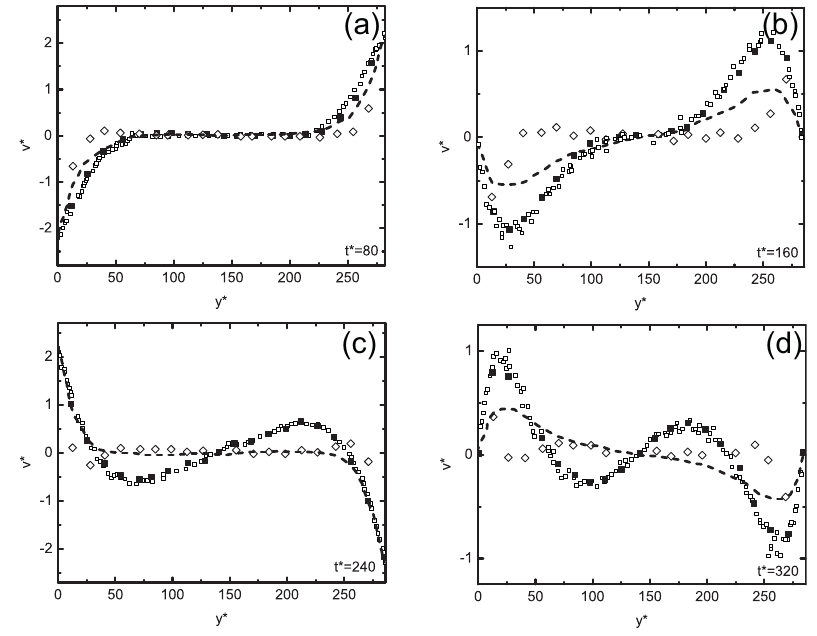
Figure 22. The velocity profiles for the FENE system with thickness, 282 σ , at different time steps. The small hollow and filled squares are given by the direct MD and concurrent multiscale simulations, respectively. The broken line is from the steady-state constitutive equation. The hollow diamonds are obtained from the concurrent multiscale simulations with equilibrated configurations freshly generated at each time. Figure reproduced with permission from